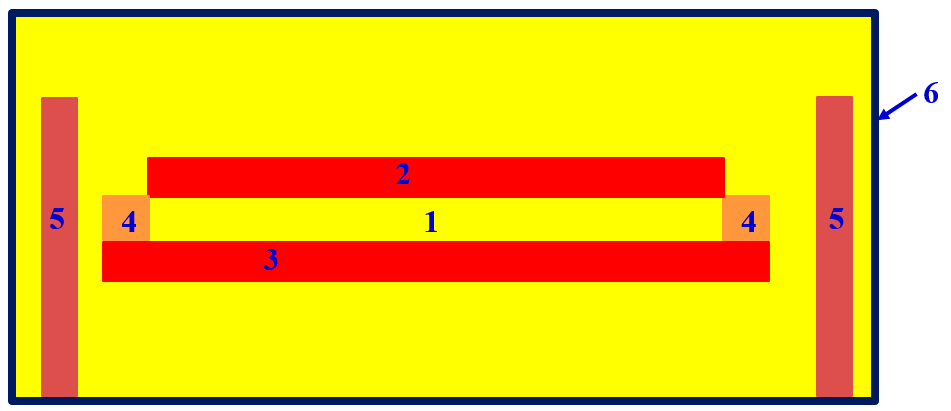
Figure 1. Diagram of the system for testing the insulating oil electrical properties. 1—mineral oil, 2—measuring electrode, 3—voltage electrode, 4—spacers (6 pieces), 5—moistened oil ‐ impregnated